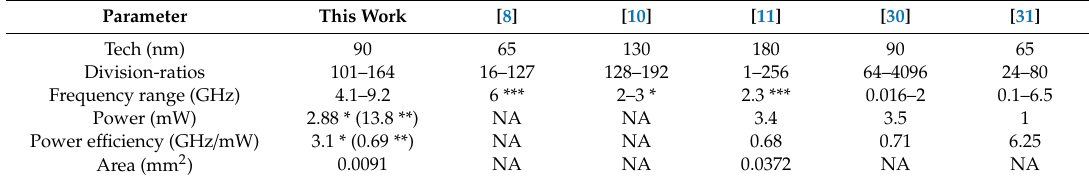
Table 3. Comparison of the performance of the pervious